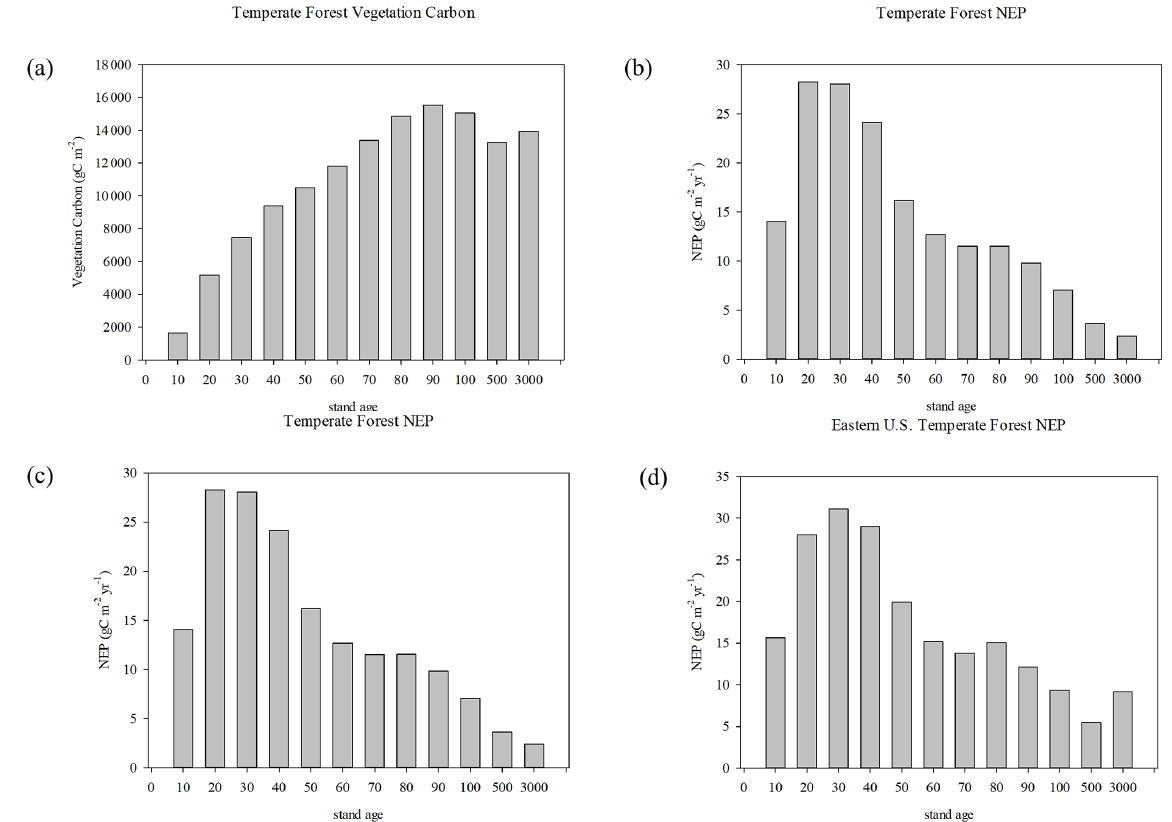
Figure 9. Vegetation carbon in the year 2014 for (a) US and (b) eastern forests, and NEP in the year 2014 for (c) US and (d) eastern forests. Most trees are not mature, but the mature trees contain the most biomass so condensing the cohorts overestimate vegetation